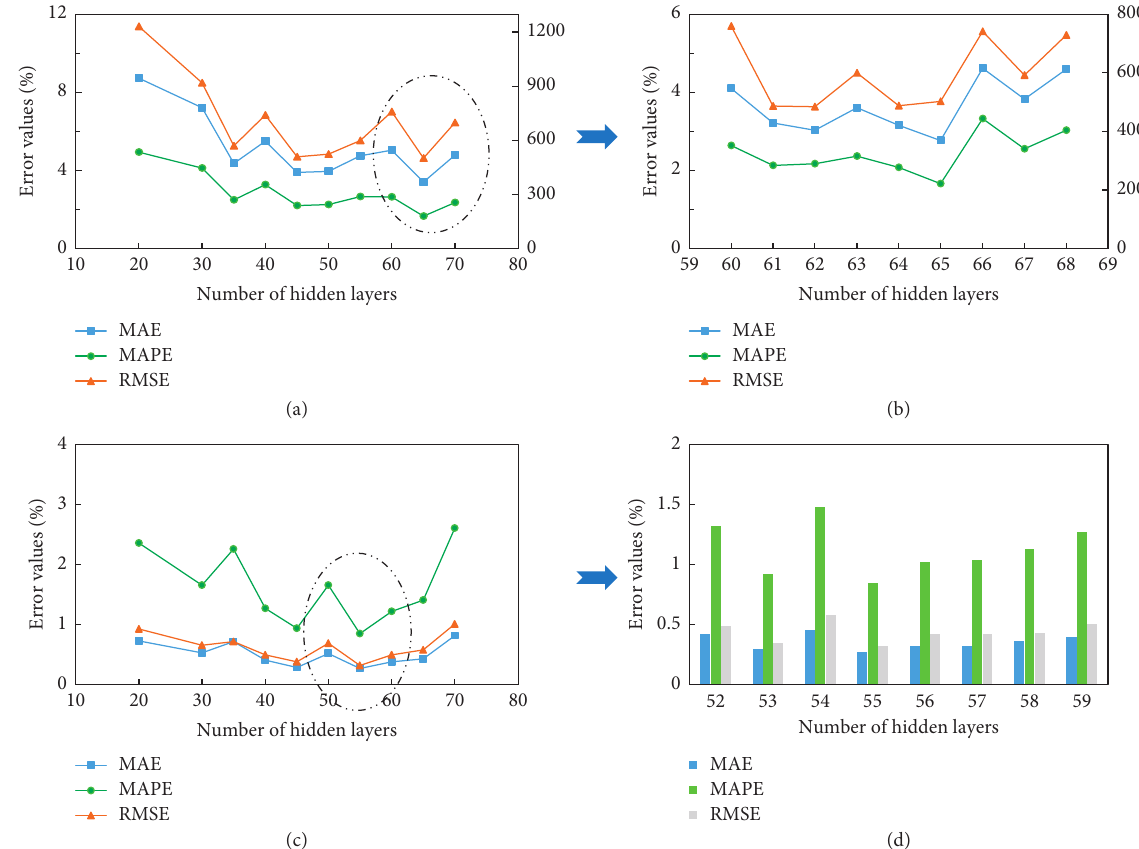
Figure 2: The optimization results of the hidden layer in the ELM model. (a) Stiffness modulus/20–70 layers. (b) Stiffness modulus/60–68 layers. (c) m -value/20–70 layers. (d) m -value/52–59